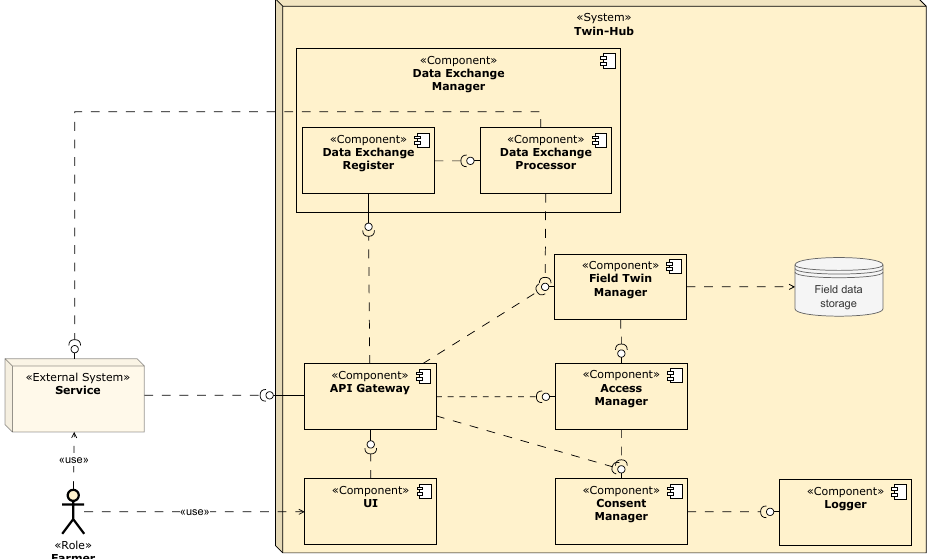
Figure 10. Final functional decomposition of the